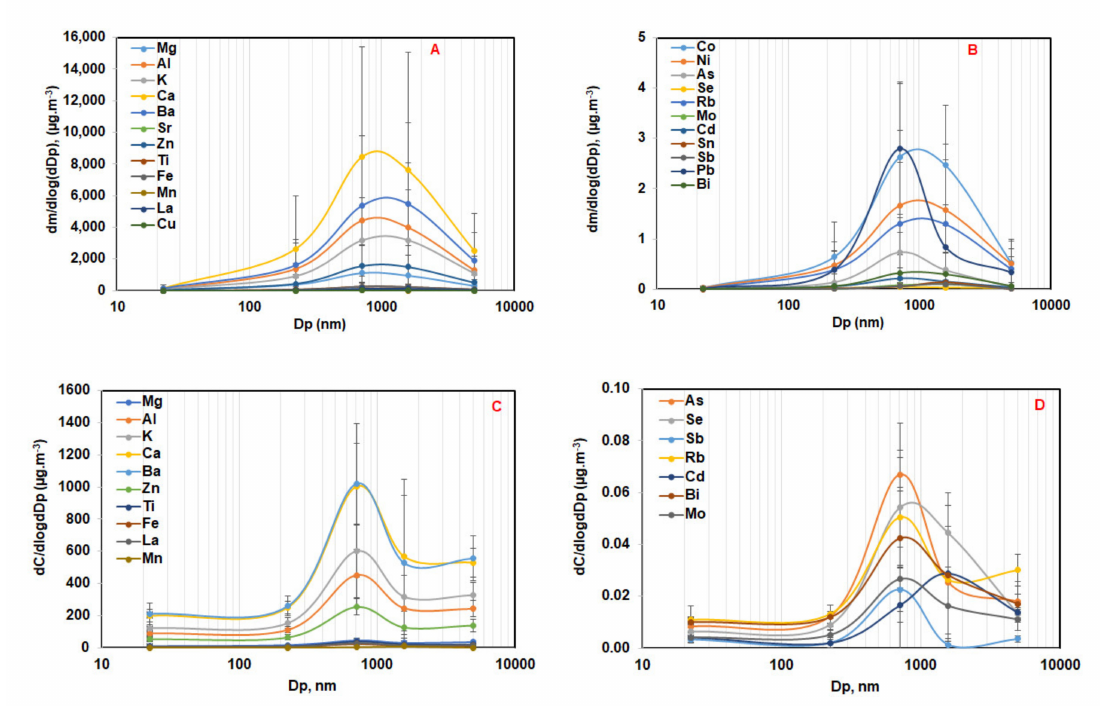
Figure 8. Average size-resolved elemental distributions of indoor airborne particles sampled during the class at S1 ( A , B ) and S2 ( C , D ). n = 80, average ± SD.